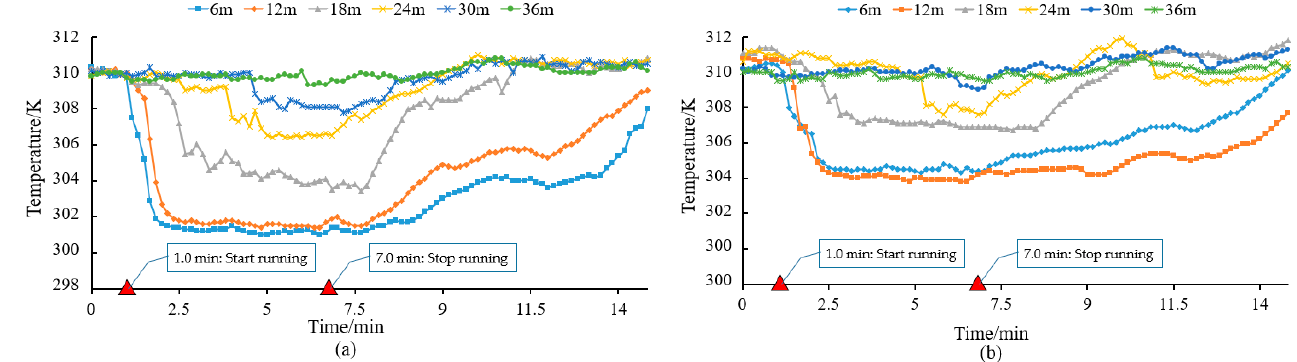
Figure 16. Temperature change curves of each test point at 1.5 m height and 0.8 m height. ( a )—Temperature change of each measuring point at 1.5 m height; ( b )—Temperature change of each measuring point at 0.8 m height.